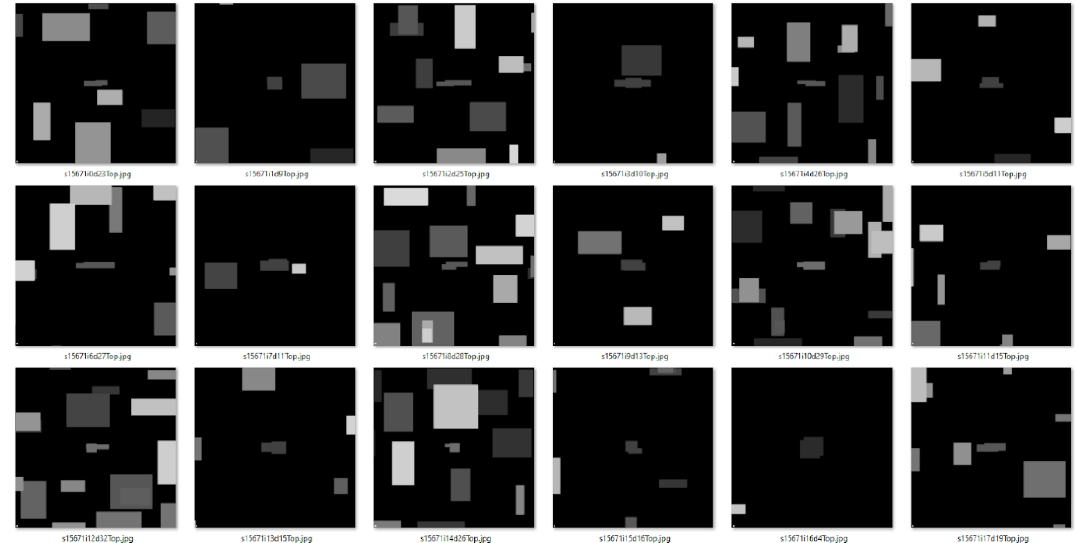
Figure 12. Randomized urban layouts for CNN training. In each case, the analyzed building is in the middle, while the surroundings represent various shading objects. The grayscale color code represents object height in linear scale, from black for the ground level (0 m), to white for 35 m and above.